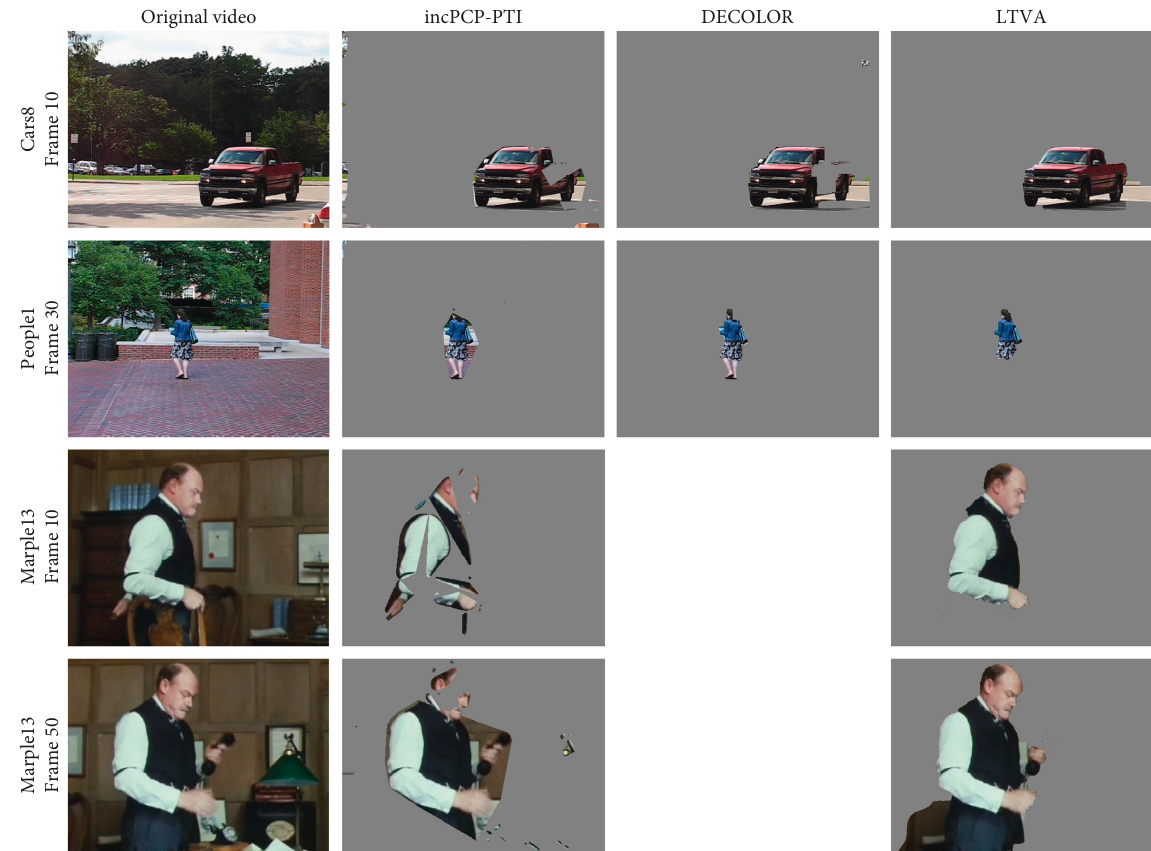
Figure 6: Selected frames from three sequences of the Moseg dataset (Section 4.2) along with the segmented sparse components for incPCP- PTI, DECOLOR, and LTVA. The sequences where DECOLOR did not work properly are left blank.